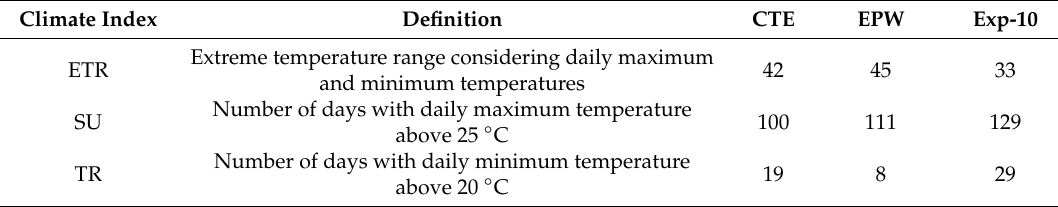
42 45 33 100 111 129 19 8